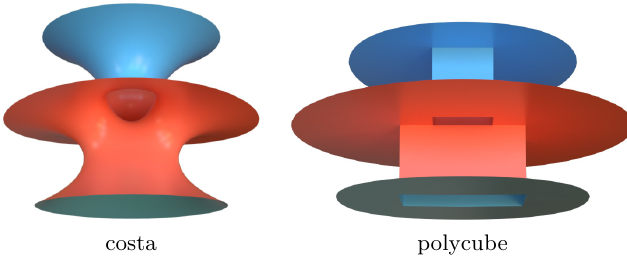
Fig. 6 Models with boundaries, and their polycube shapes.